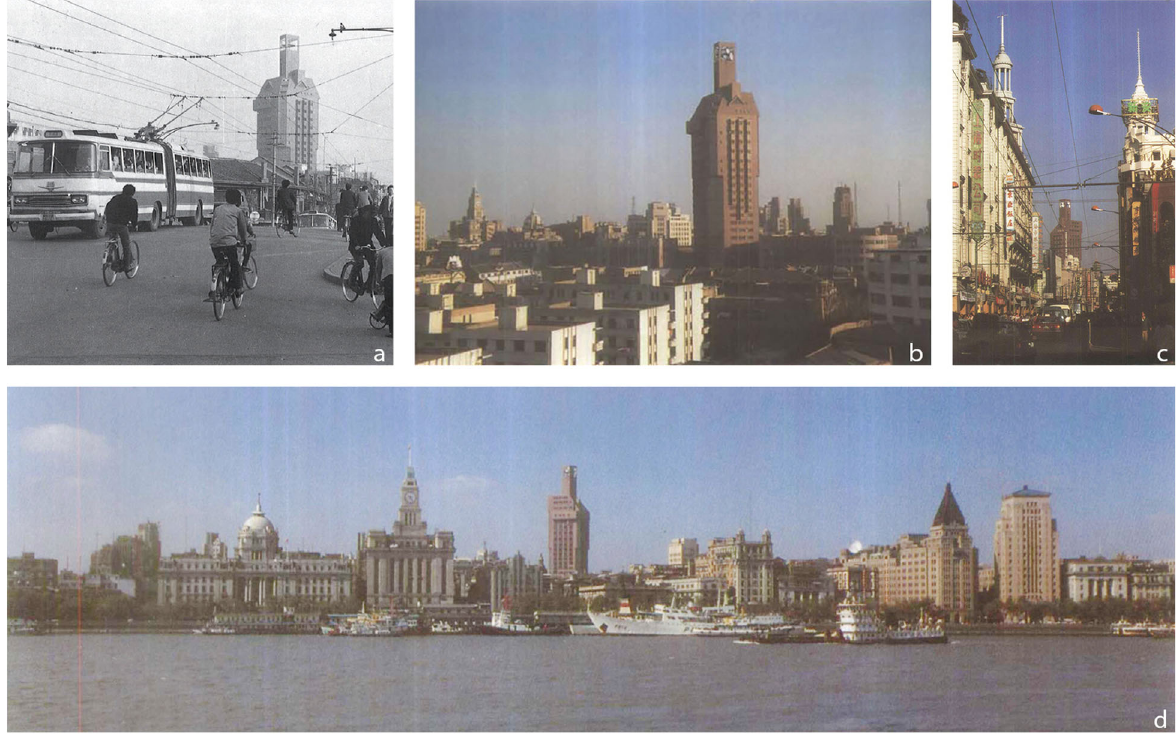
Fig. 7 SECEP Building in its urban context in the late 1980s and early 1990s (Source: a ECADI; b – d Xiao